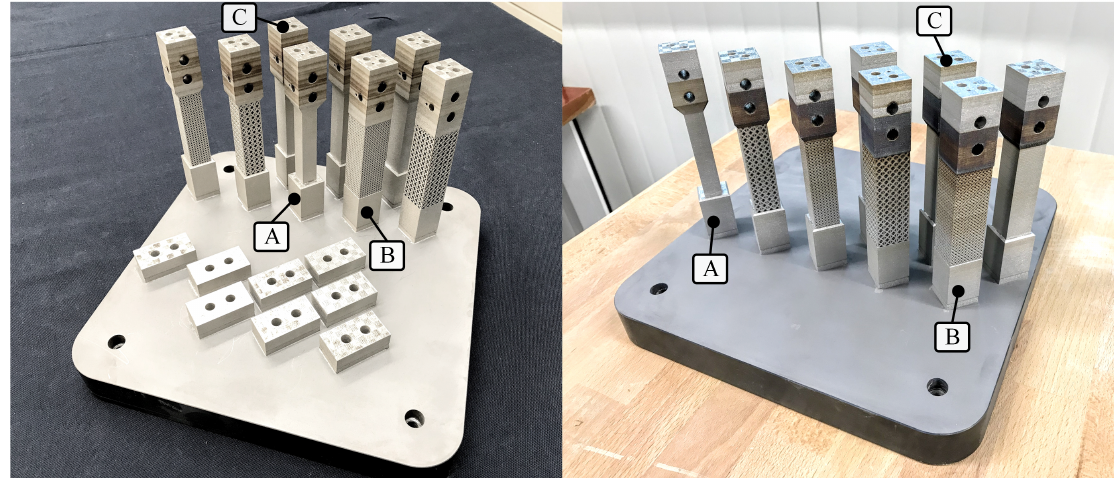
Figure 2. SLM-manufactured 316L specimens: first ( left ) and second ( right ) replicates.